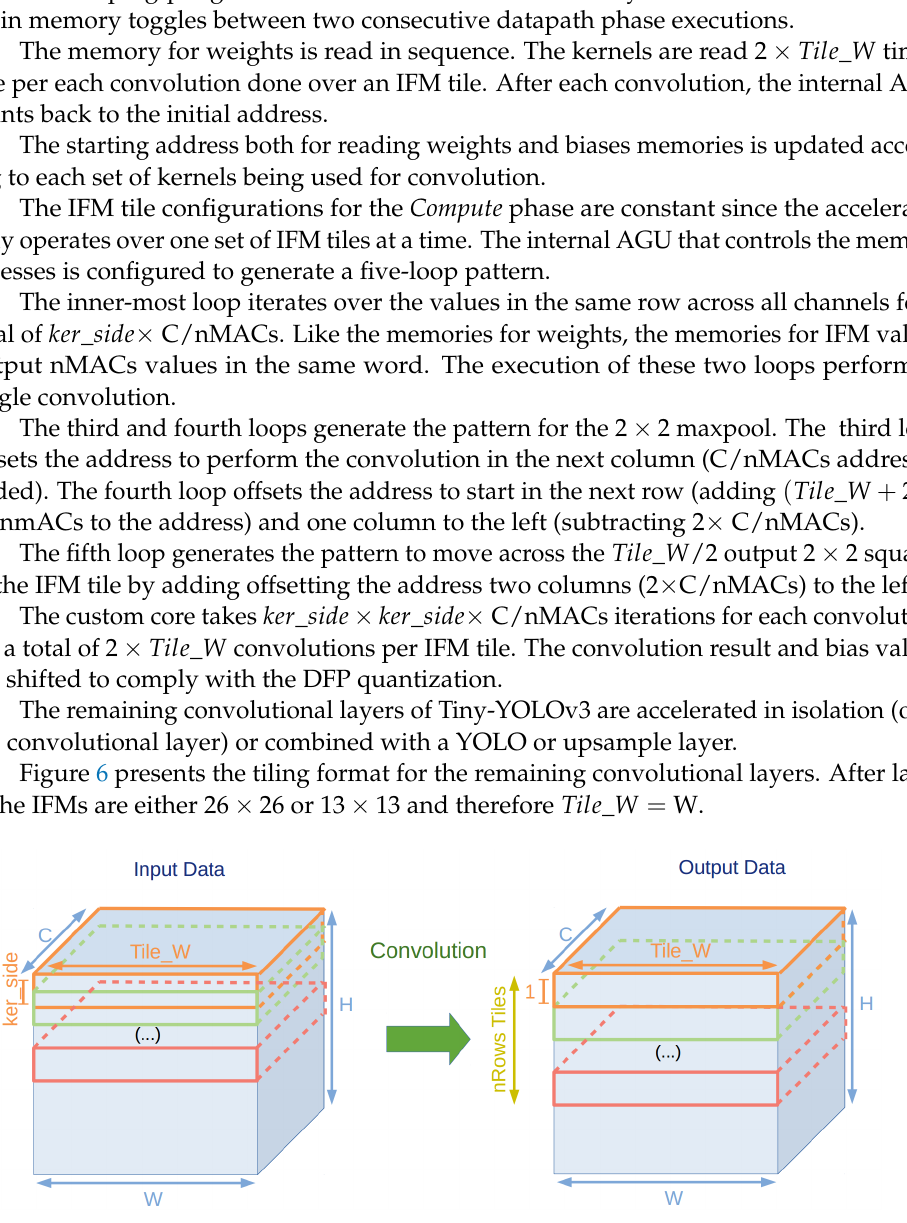
Figure 6. Data tiling diagram after layer